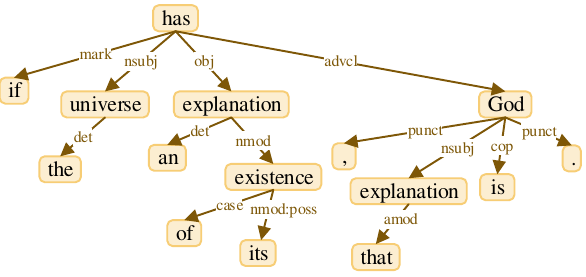
Figure 1. Graph structure of an example produced by Stanford dependency grammar.